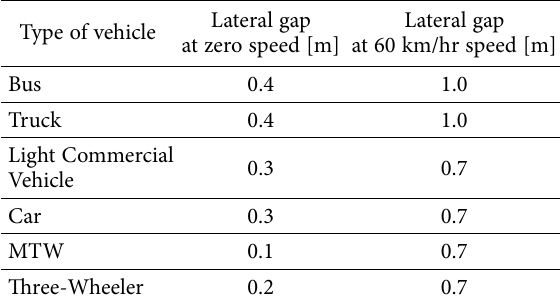
Table 2. Gaps maintained by various types of vehicles at 0 and 60 km/hr speed (Nagaraj et al. 1990)